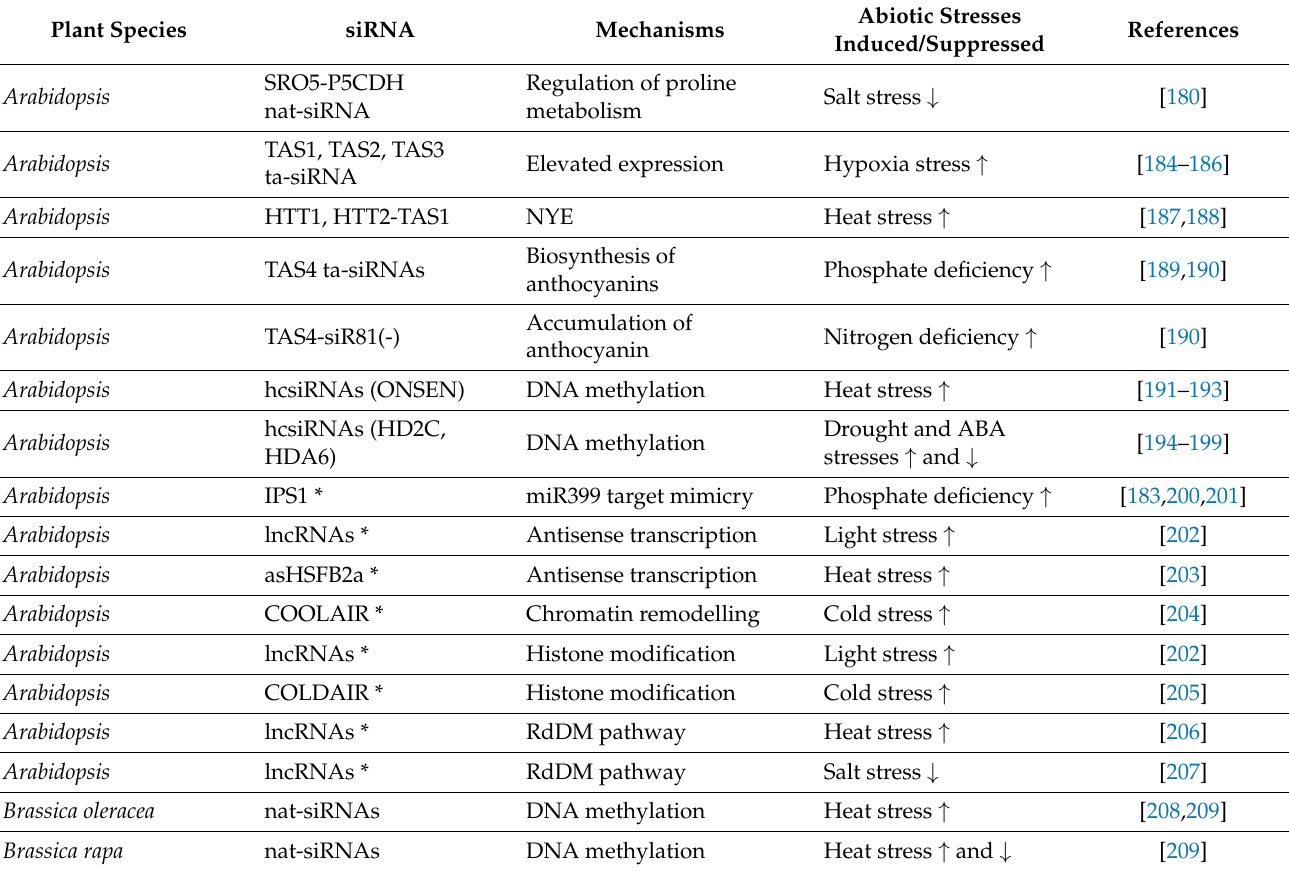
Table 3. Abiotic stress response mechanisms of non-coding RNAs (siRNAs and lncRNAs) from various plant species. Plant